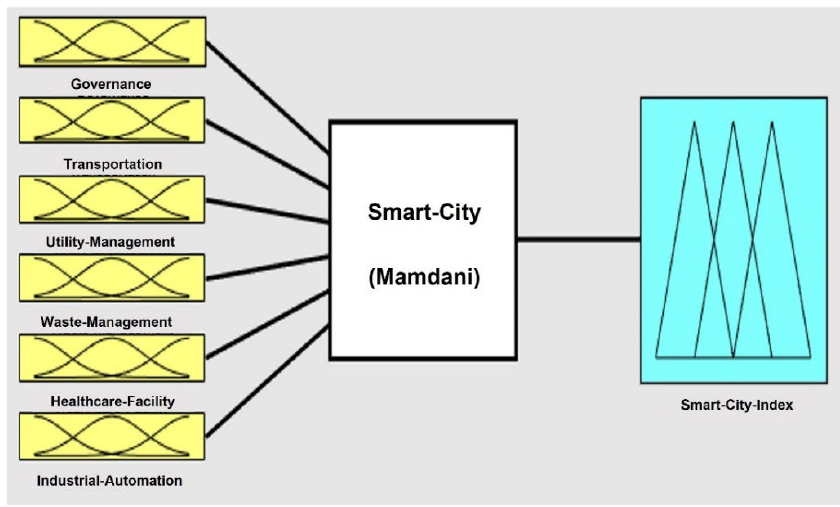
Figure 4. Fuzzy rule-based smart city prediction tool considering six input parameters.